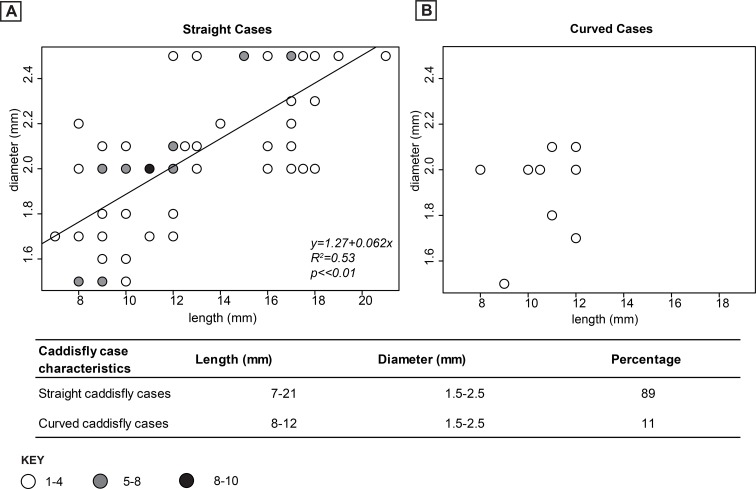
Caddisfly case size variations.(A) Size distribution of the straight caddisfly cases. (B) Size distribution of the curved caddisfly cases. (1–10)- Number of caddisfly cases.